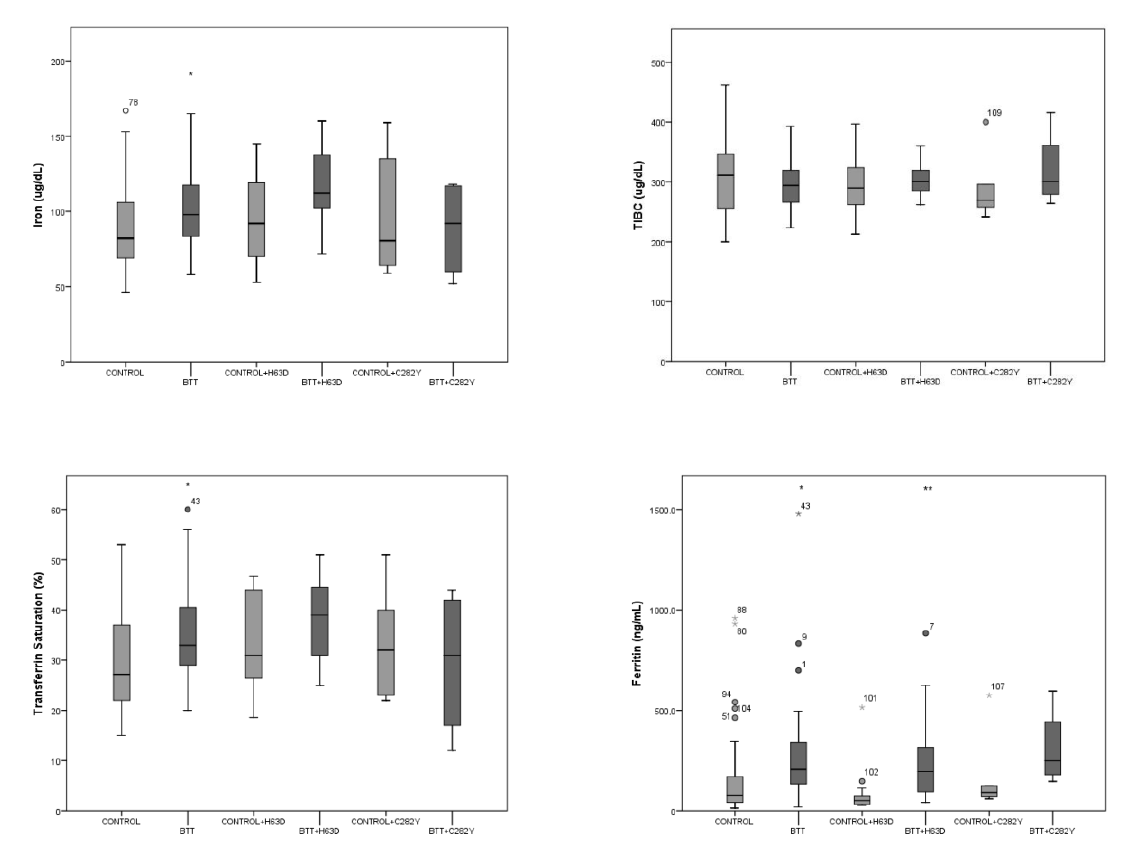
Figure 1. Iron parameters according the presence of HFE mutation in the groups under study. Abbreviations: TIBC, total iron binding capacity. * p < 0.05 compared to control; ** p < 0.05 compared control + H63D. The number case is included in